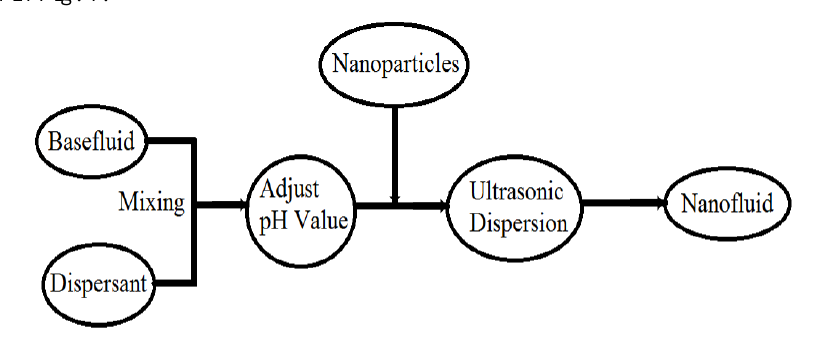
Fig. 1. Diagram of nanofluid preparation flow chart